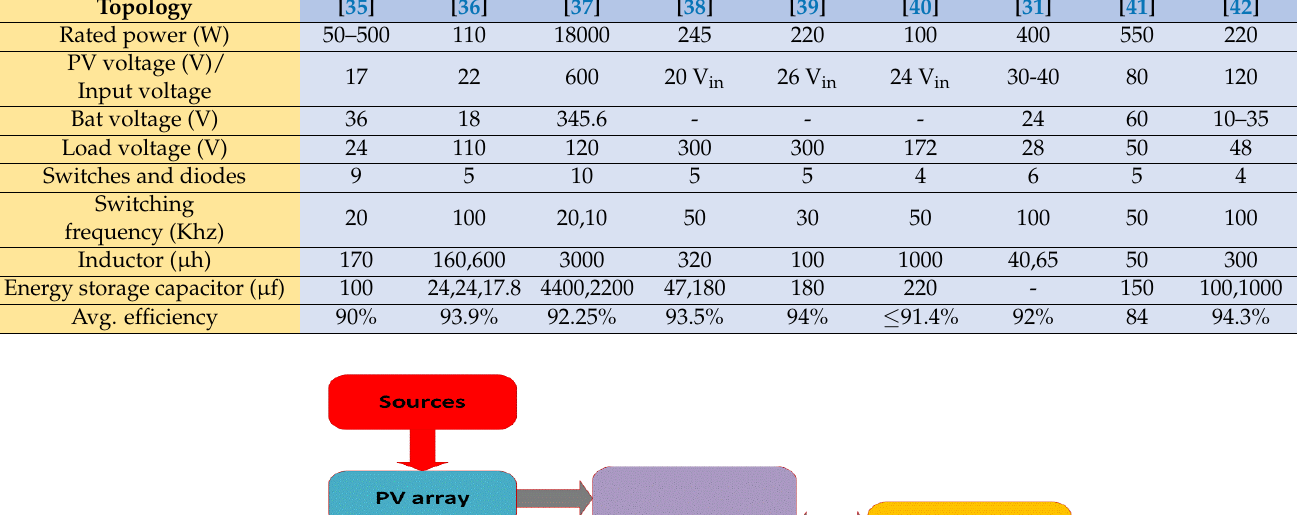
Table 2. Reported parameters for NI topologies.